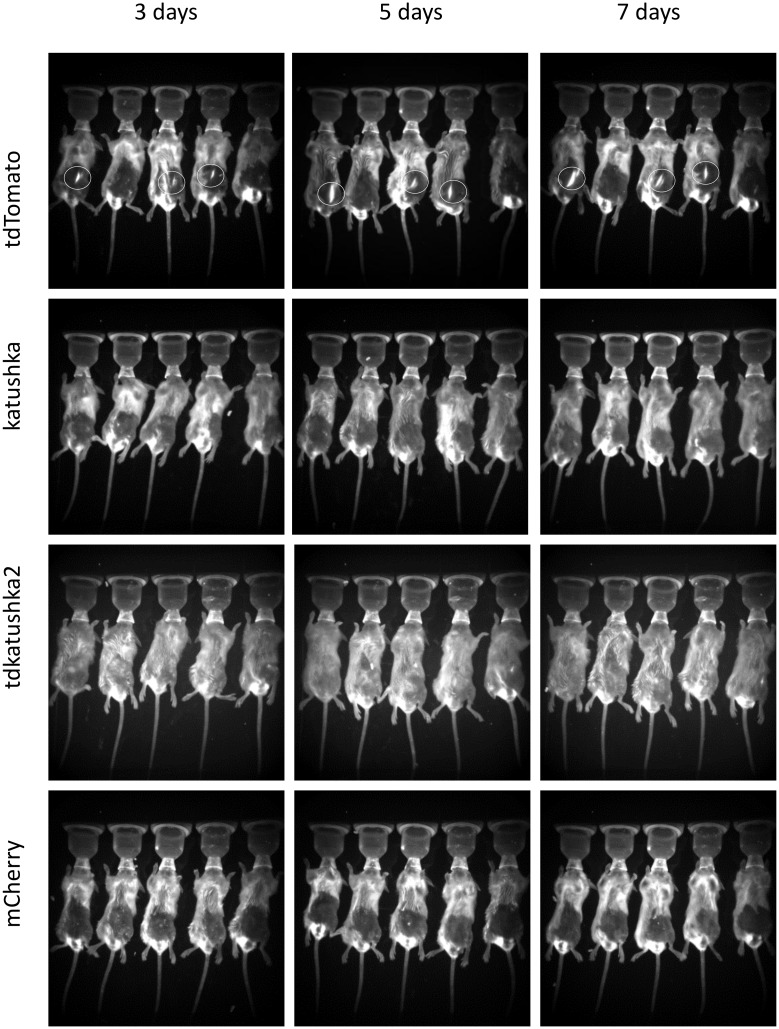
Comparison of red fluorescent proteins after subcutaneous DNA delivery.Mice were injected s.c. with 50μg DNA in the epigastric region and the site electroporated. At days 3, 5 and 7 after transfection, mice were imaged in vivo using an Imaging System at 550nm excitation and 600nm emission. Representative of n = 3 experiments. White circles indicate fluorescent protein expression.